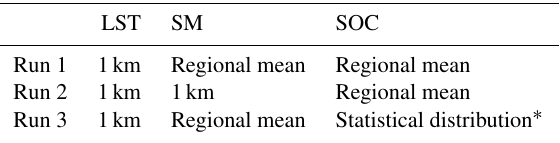
Table 3. Model drivers for the three model sensitivity runs con- ducted within the Alaska DH sub-region. The model LST and SM inputs were derived from MODIS (MOD11A2) observations and airborne radar SM